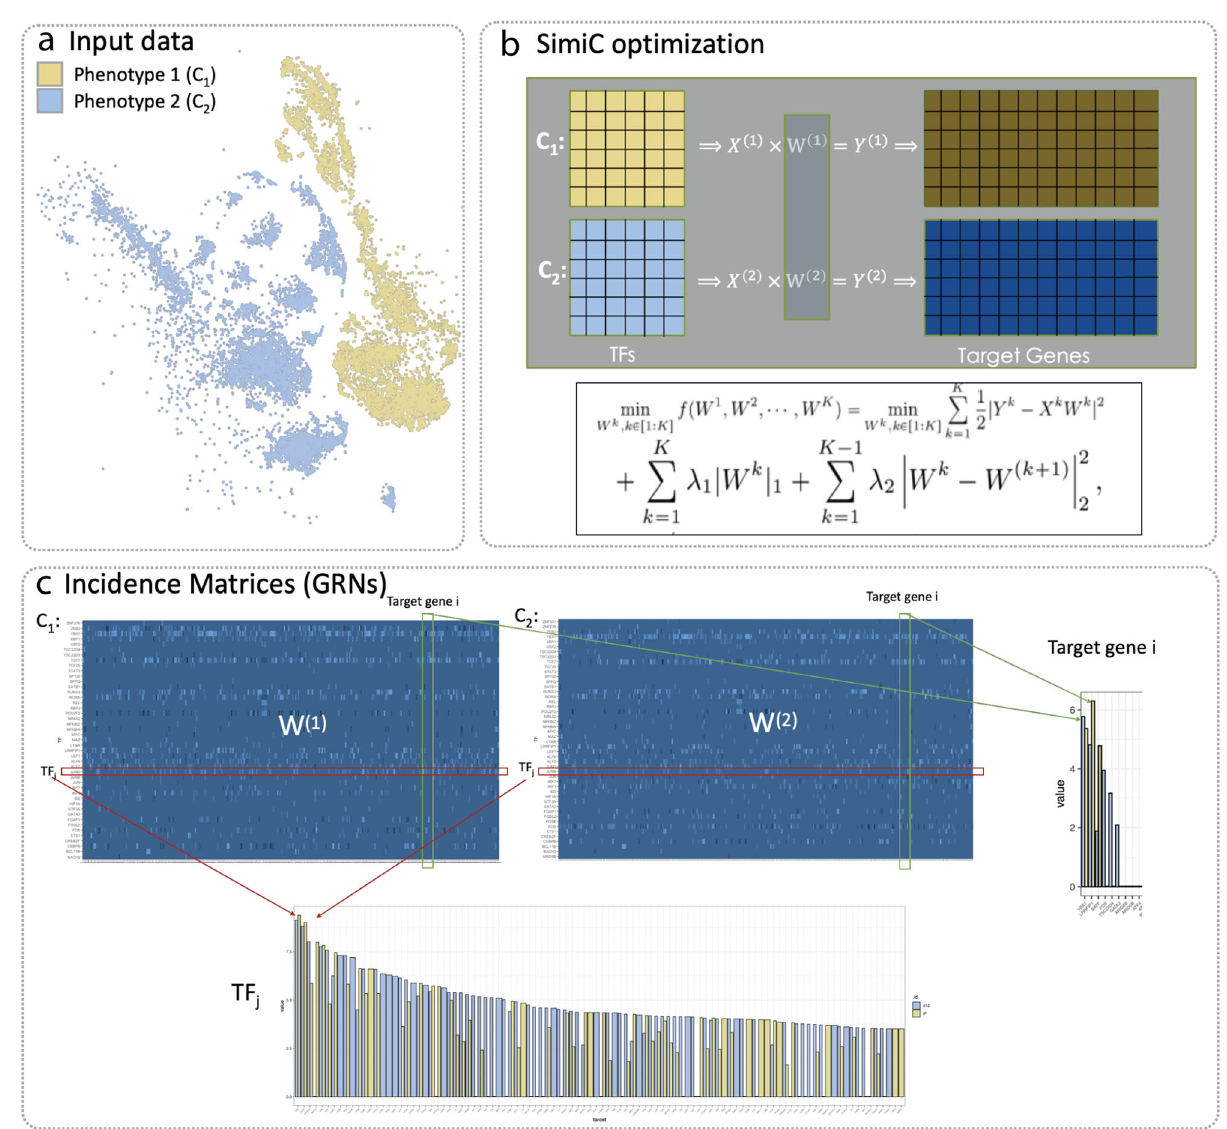
Fig. 1 Work fl ow of SimiC. a Example of input data to SimiC consisting of the imputed cell expression data of cells with phenotype 1 ( C 1 ) and phenotype 2 ( C 2 ). The data is visualized in the tSNE-reduced space, where the color indicates the cell phenotype. b SimiC objective function based on LASSO 32 with an added similarity constraint. The W ( i ) s represent the inferred incident matrices, and the X ( i ) s and Y ( i ) s the expression matrices of the driver and target genes, respectively. The superscripts correspond to the cell phenotypes ( K in total). λ 1 and λ 2 are hyperparameters to control the weights of the regularization terms. c Incidence matrices inferred by SimiC, one per phenotype. The dimension is the number of driver genes, such as transcription factors (TFs), by number of target genes. Weight W i , j represents the in fl uence of the i th TF in the j th target gene. The bar plots show the differences in the inferred weights for a given TF and target gene for the two phenotypes (indicated by